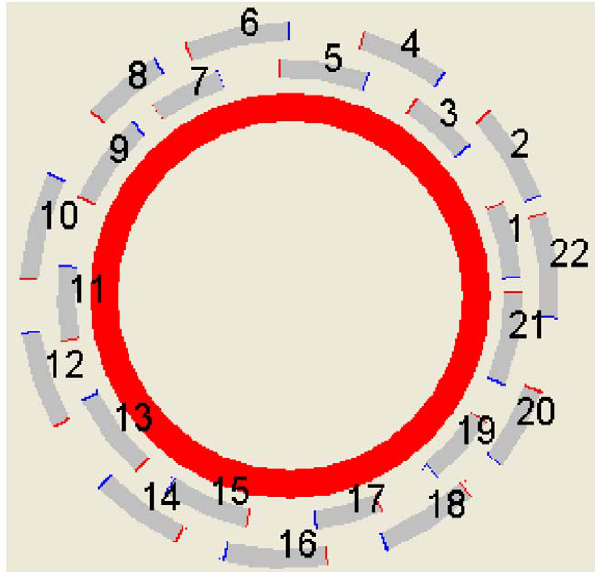
Figure 6. A set of conserved primer pairs for sequencing an entire mitochondrial genome.